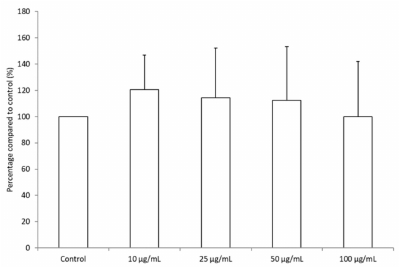
Figure 2. BRE did not a ff ect leukocyte viability. Cells were treated with the indicated concentrations of BRE for 2 h, and then cell viability was measured. Data were shown as means ± SD (Control = 100%); * p < 0.05 compared with Control.